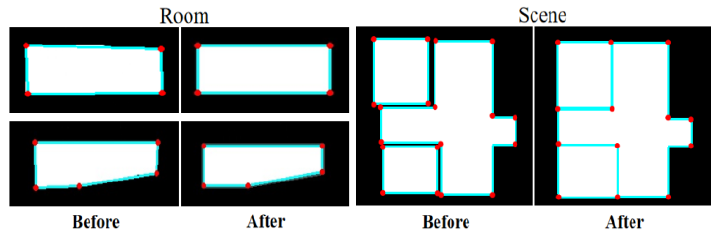
Figure 7. Result of edge optimization.